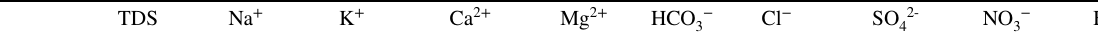
Table 9 Correlation matrix between physicochemical parameters